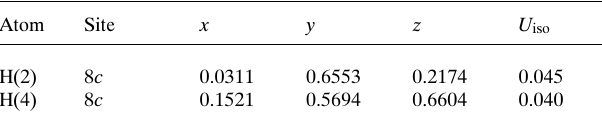
Table 2. Atomic coordinates and displacement parameters (in Å 2 )